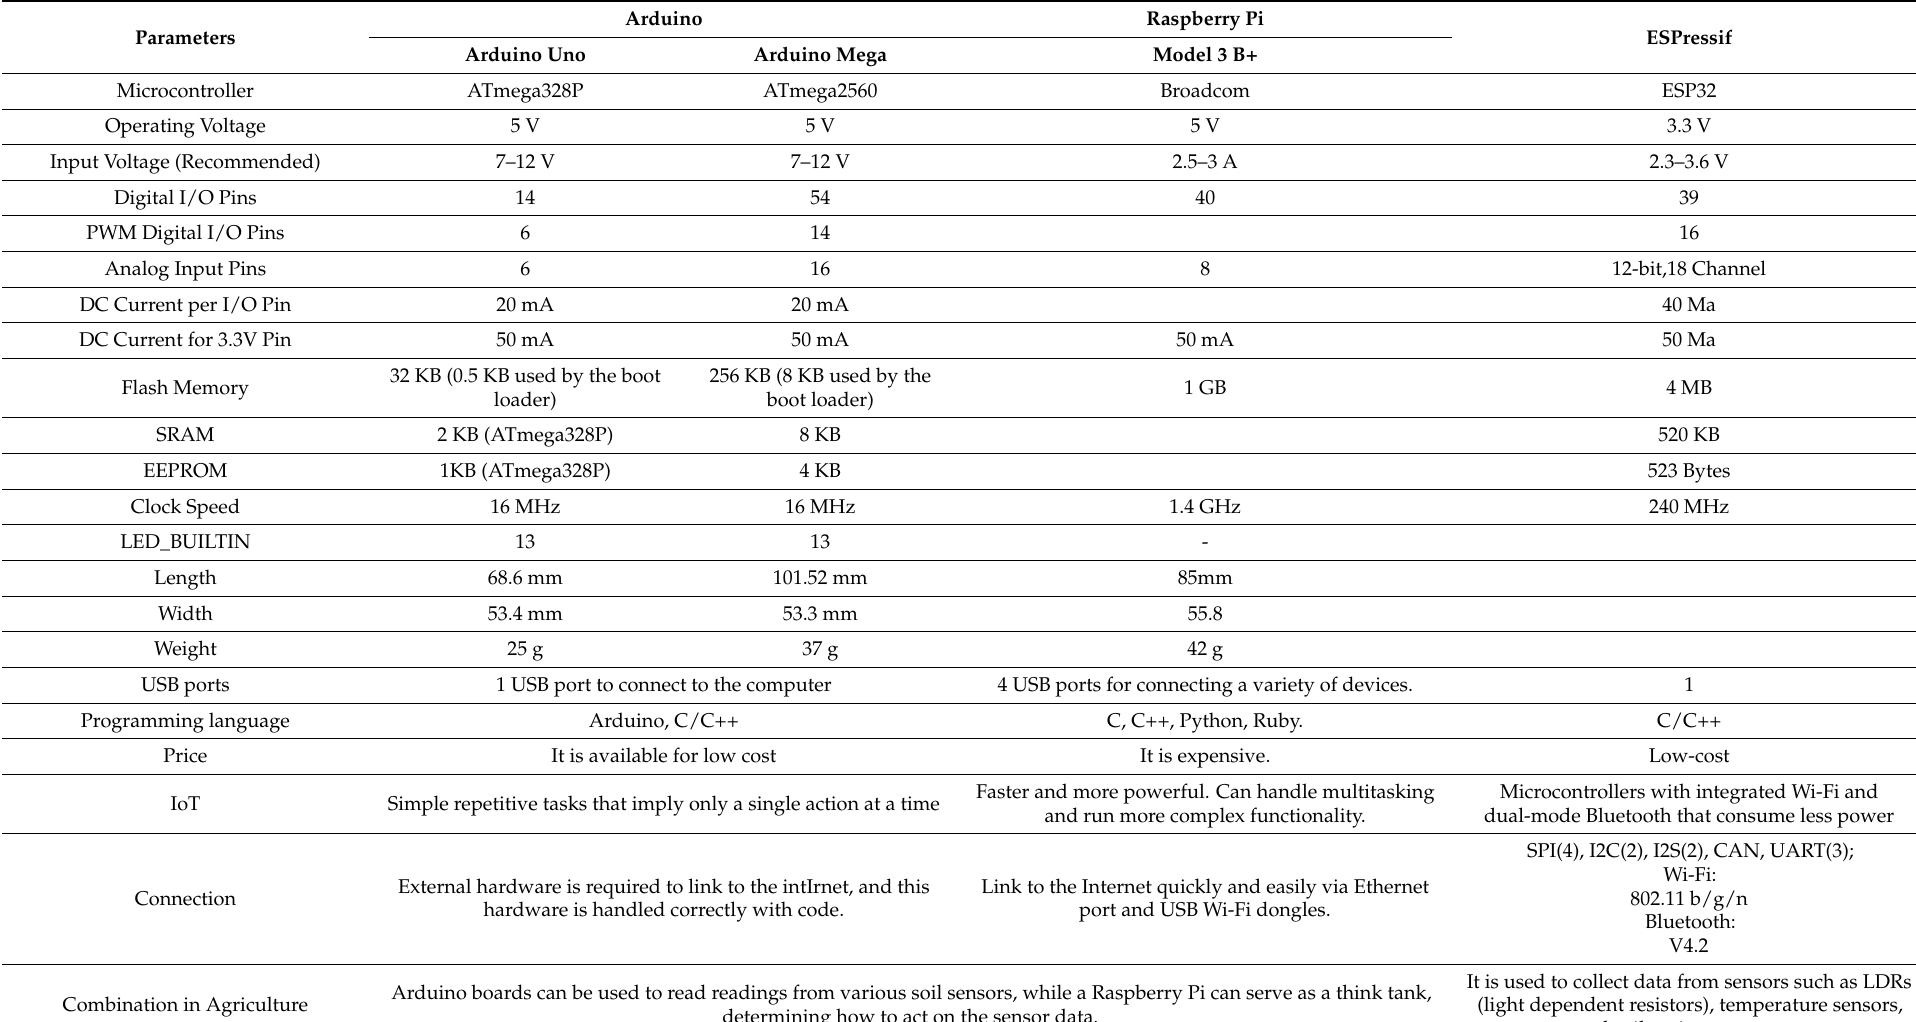
Table 4. IoT supported hardware controller board utilized in smart